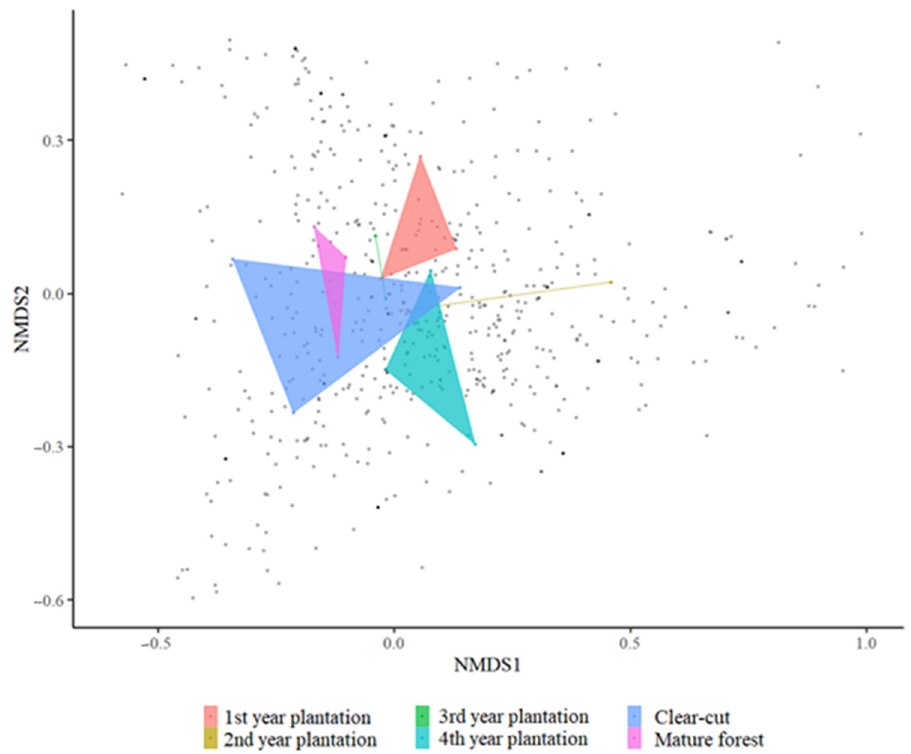
The assignment of fungal ecological roles (trophic groups) is represented in Figure 5. Figure 4. Nonmetric multidimensional scaling (NMDS) ordination of the fungal communities in the